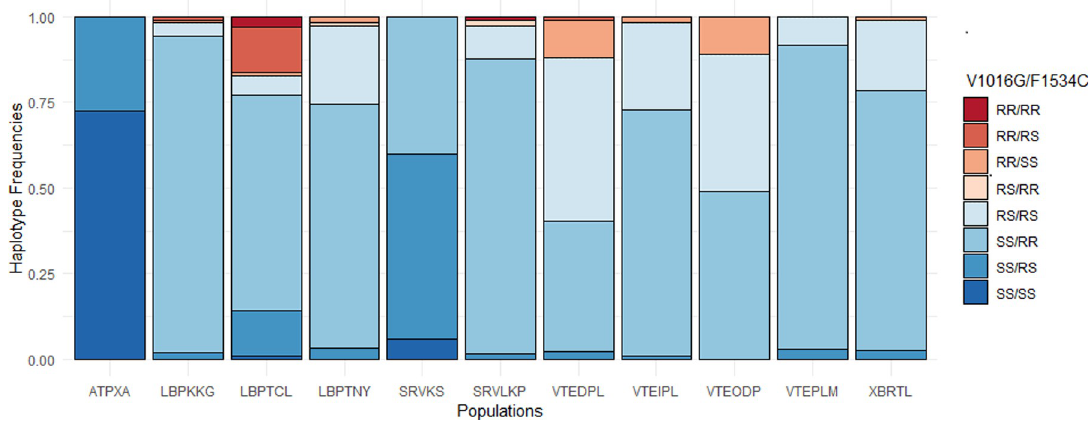
Fig 5. Haplotypes frequencies of V1016G and F1534C kdr mutations in Aedes aegypti populations from Laos.